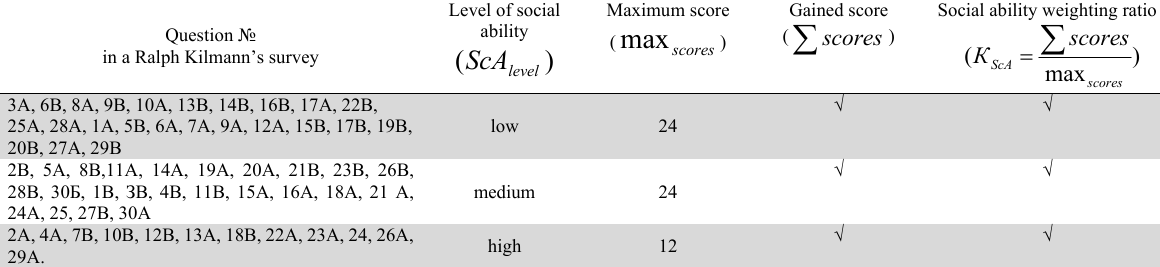
The interpretation of survey scores for a personal ScA